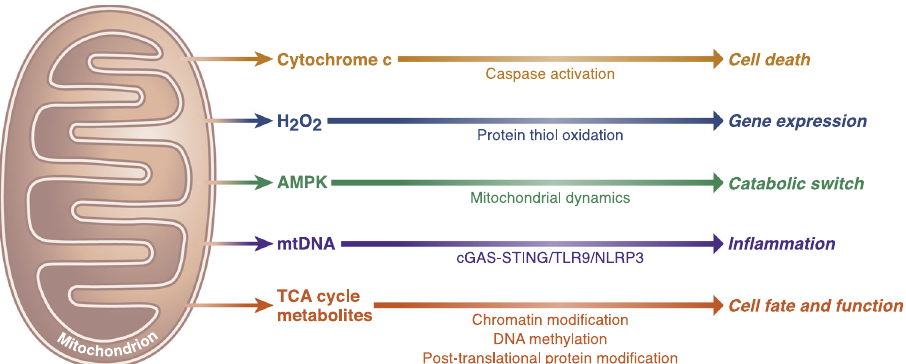
Fig. 1 Essential signaling functions of mitochondria. Mitochondria have evolved distinct strategies to integrate environmental cues and communicate their fi tness to the rest of the cell to maintain cellular homeostasis. Release of cytochrome c to invoke caspase-dependent cell death, release of reactive oxygen species to oxidize thiols within redox-regulated proteins, and induce gene expression and the activation of AMPK under energetic stress to control mitochondrial dynamics are three prominent mitochondrial-dependent signaling events. Additionally, release of mitochondrial DNA into the cytosol triggers in fl ammasome activation and pro-in fl ammatory responses through the cGAS – STING cytosolic DNA-sensing pathway. Signaling roles of TCA cycle metabolites are in part mediated by controlling chromatin modi fi cations and DNA methylation, as well as post-translational protein modi fi cations.